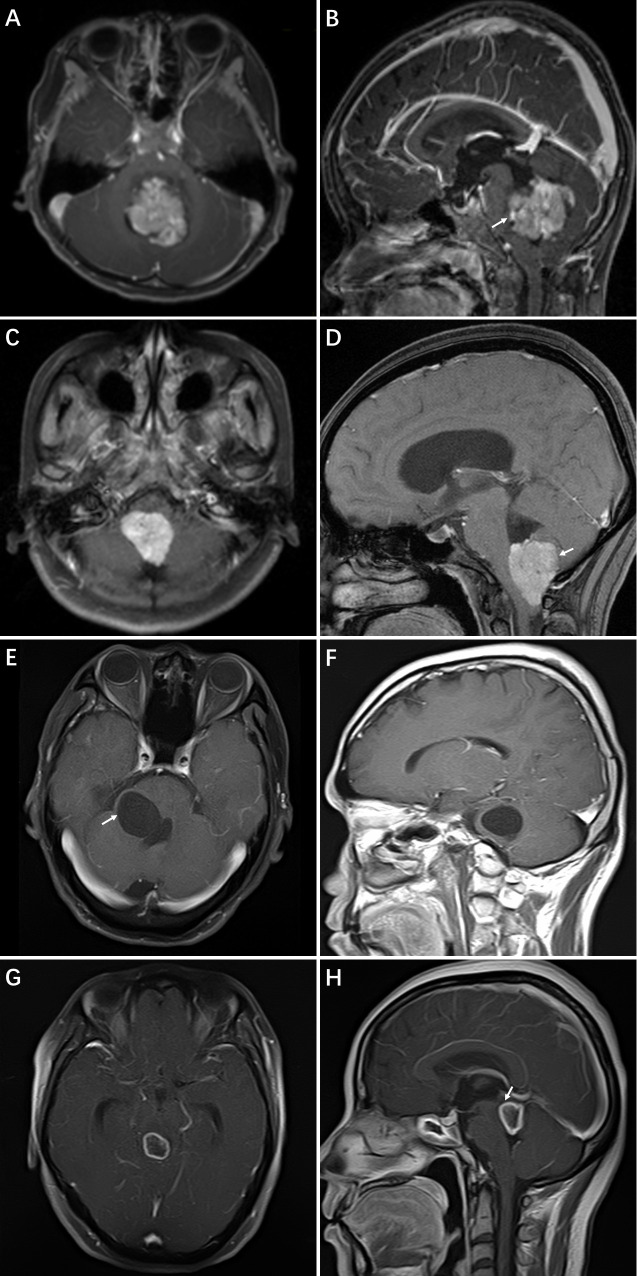
Cases of extension of fourth ventricle tumor.(A and B) The axial and sagittal contrast-enhanced T1-weighted image shows the lesion invading into the brainstem. (C and D) The axial and sagittal contrast-enhanced T1-weighted image shows the lesion invading into the foramen magnum. (E and F) The axial and sagittal contrast-enhanced T1-weighted image shows the lesion invading into the left foramen of Luschka. (G and H) The axial and sagittal contrast-enhanced T1-weighted image shows the lesion invading into the aqueduct of Sylvius.